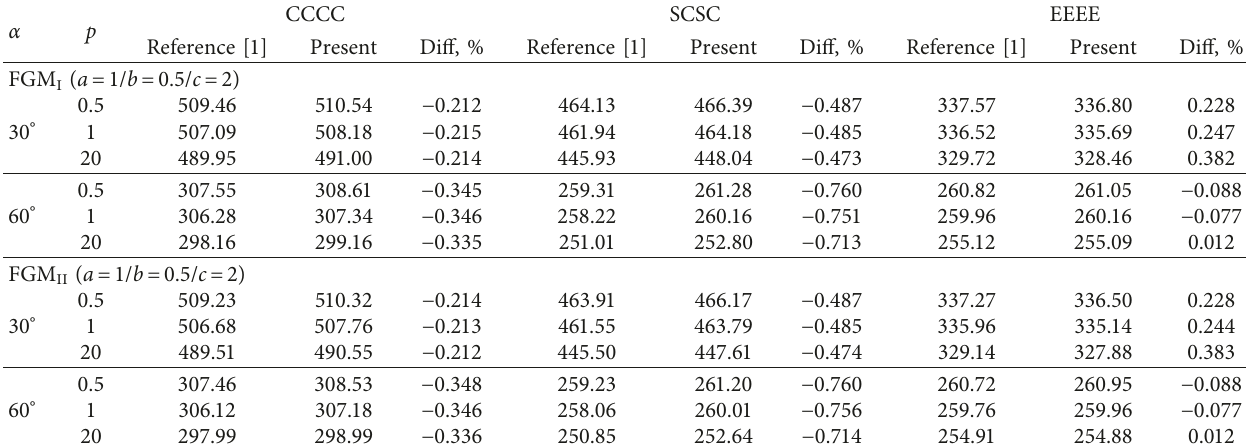
Table 3: Comparison of fundamental frequencies (Hz) for functionally graded open conical shells with various boundary conditions